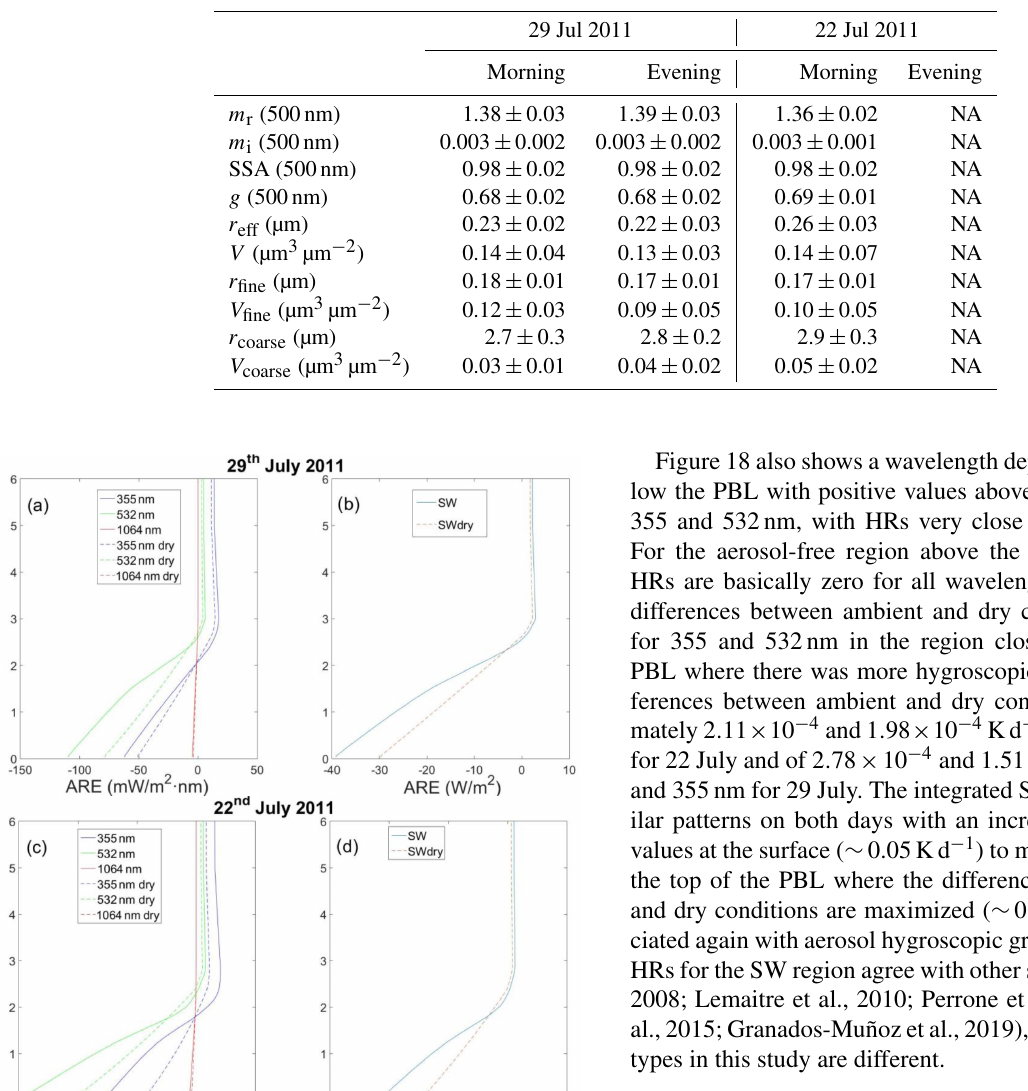
Table 5. Mean real refractive index ( m r ), imaginary refractive index ( m i ), single scattering albedo (SSA), asymmetry factor ( g ), effective radius ( r eff ), particle volume ( V ), fine-mode radius ( r fine ) and volume ( V fine ) and coarse-mode radius ( r coarse ) and volume ( V coarse ) obtained from AERONET Level 2.0 inversions on 29 and 22 July 2011.